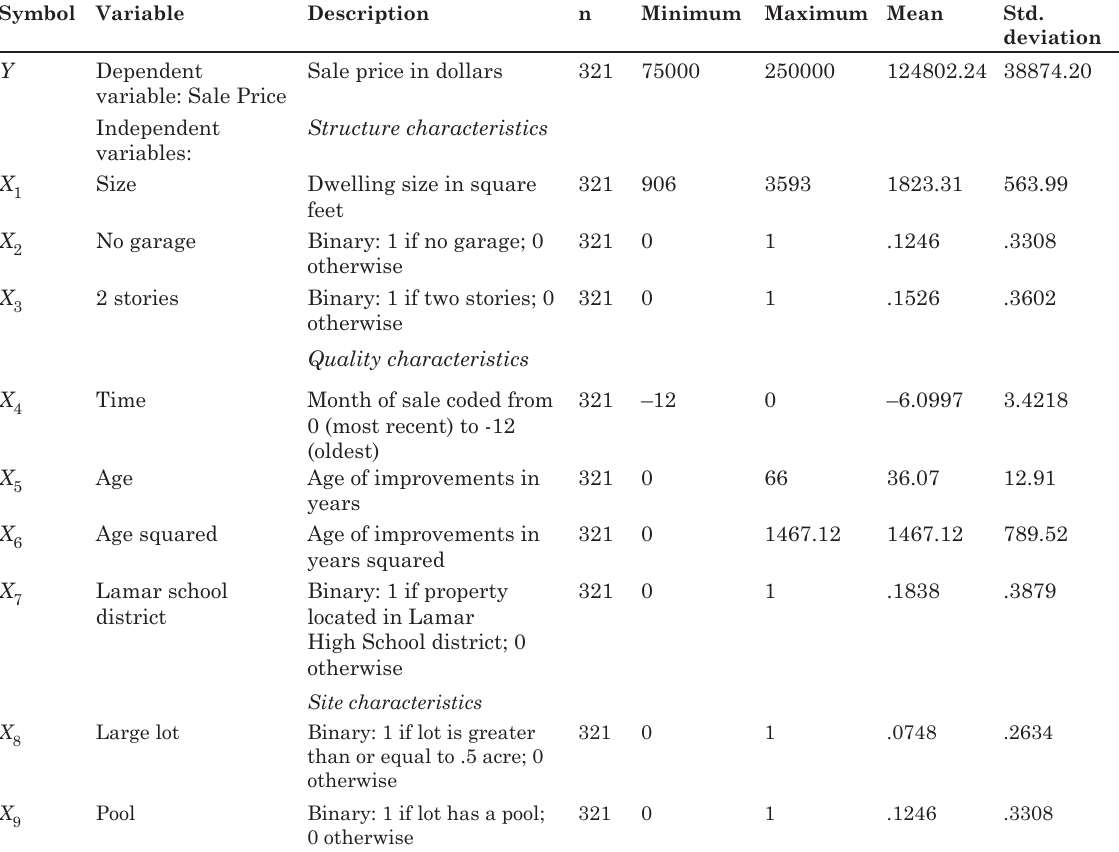
table 2. Variable definitions and descriptive